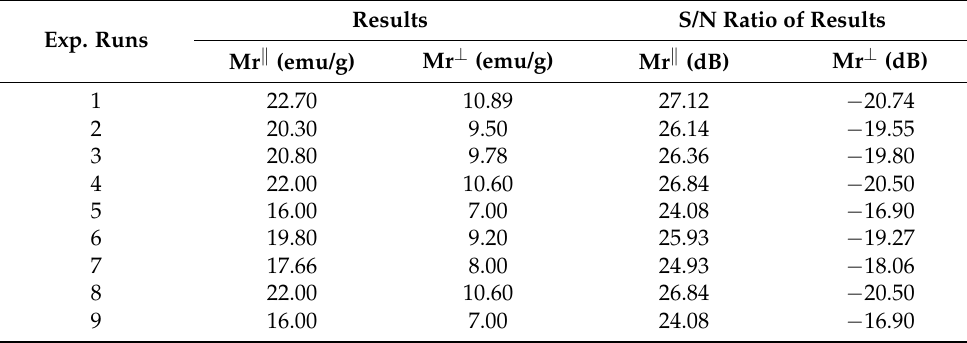
Table 4. The results of experiments and the calculated S/N ratio. Exp.